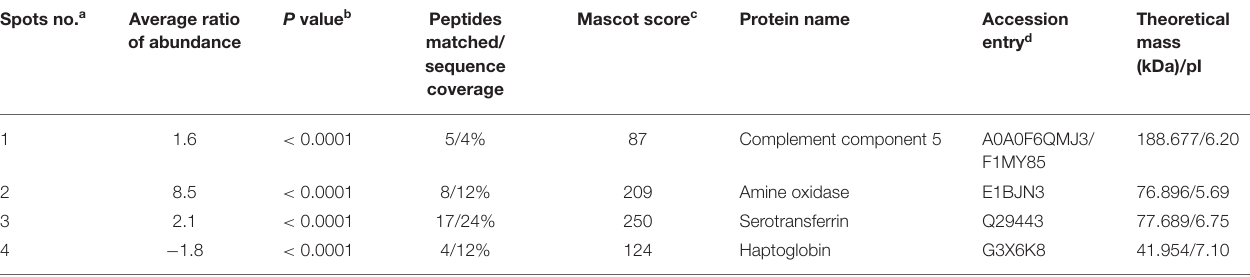
a Numbers correspond to spots circled in Figure 2 . b Student’s